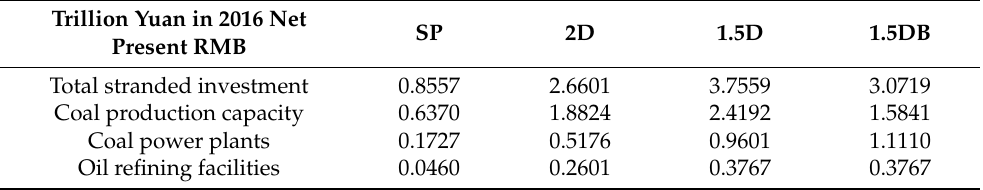
Table 5. Stranded investment on fossil energy infrastructure.